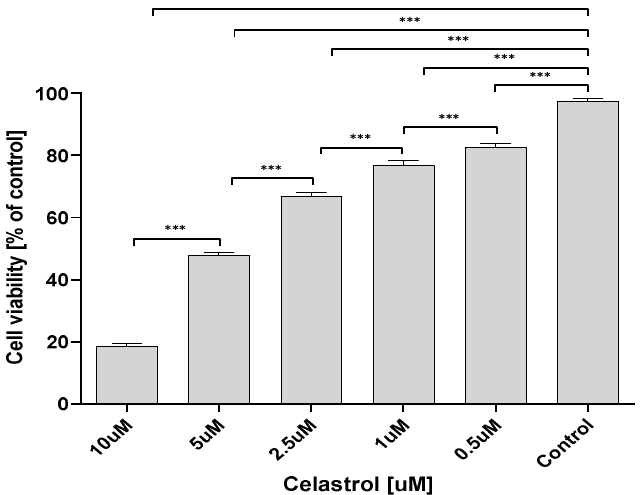
Figure 1. Trypan blue cell viability assay. The U251MG glioblastoma multiforme cells were treated with celastrol (0, 0.5, 1, 2.5, 5 and 10 µ M). The data are presented as the means ± the SEM of six independent experiments. Statistically significant *** p < 0.001. A celastrol concentration of 1 µ M was selected for further